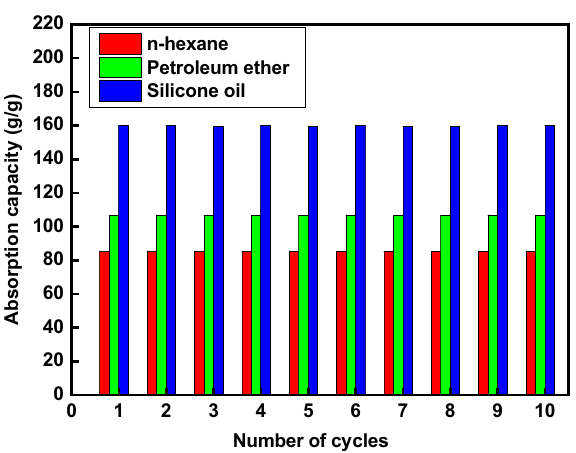
Figure 7. Images of water droplets at the pristine surface ( a ) and modified textile fabric ( b ).